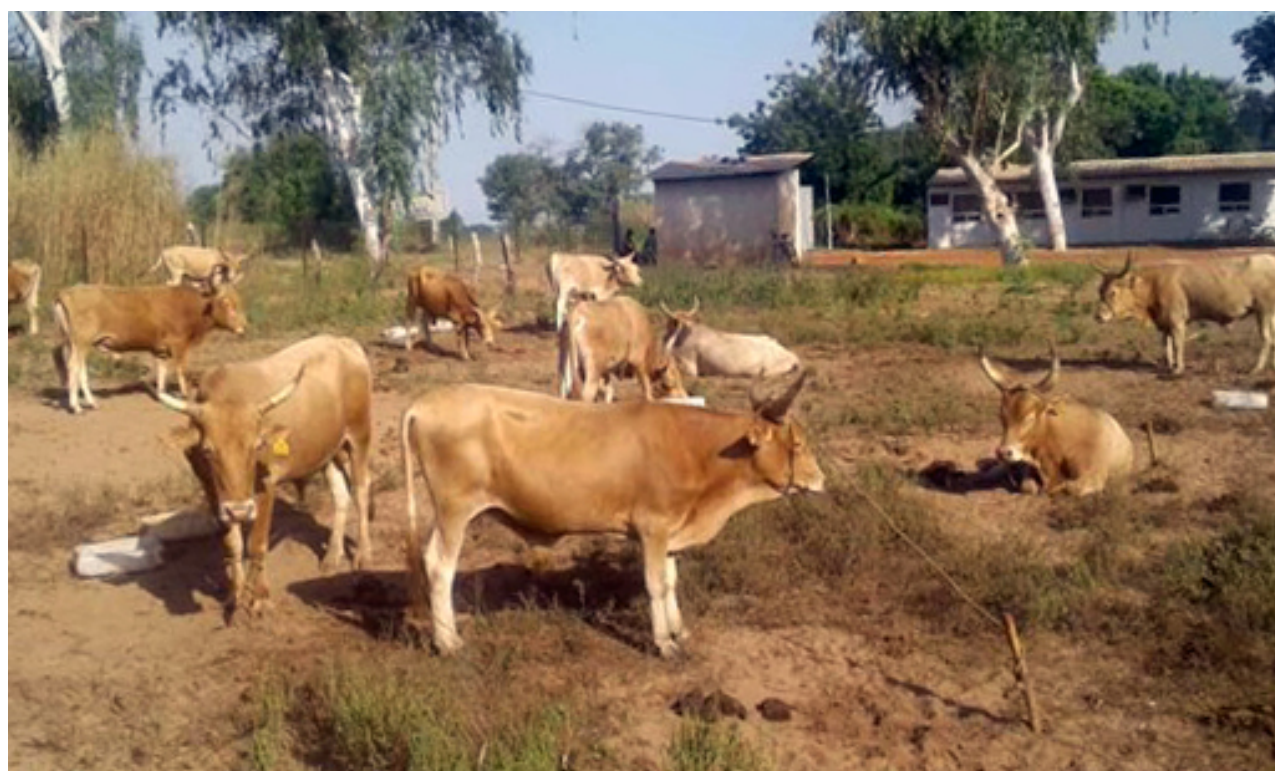
Figure 1. Selected N’Dama cattle breeding bulls in 2019 for the Multiplier tier. Photo: Arss